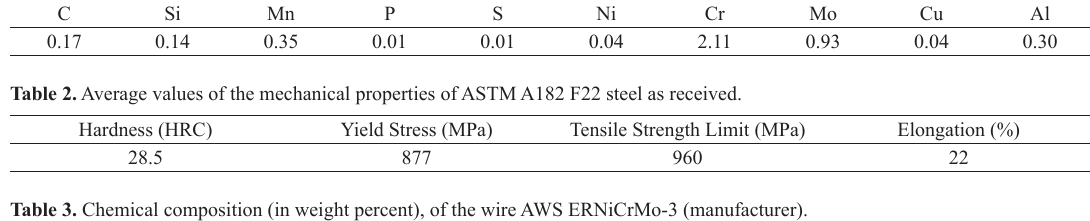
Table 3. Chemical composition (in weight percent), of the wire AWS ERNiCrMo-3 (manufacturer). Ni